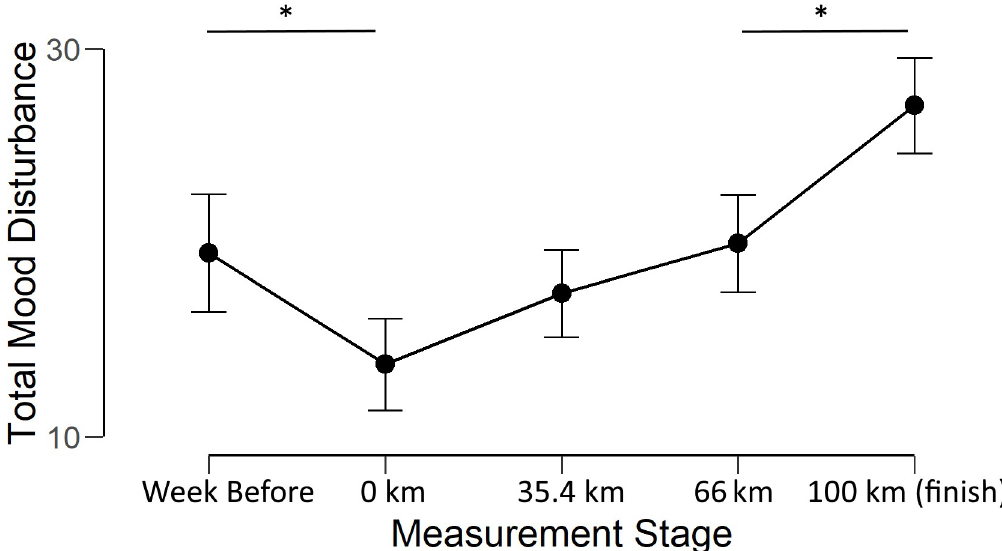
Fig 2. Total Mood Disturbance score at each measurement stage. Error bars show 95% confidence intervals. � indicates a statistically significant difference.